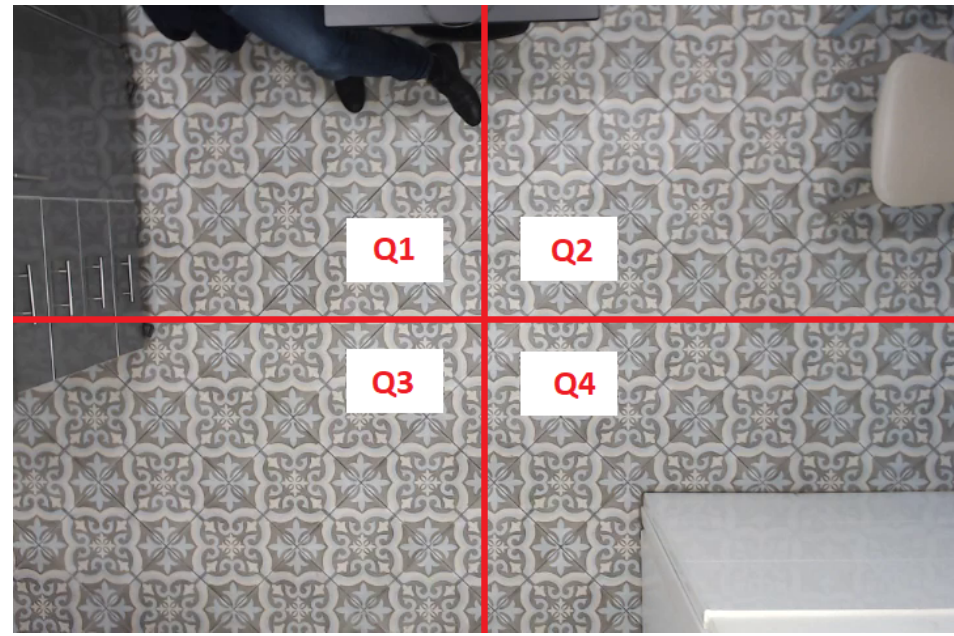
Figure A3. Consultation room divided into